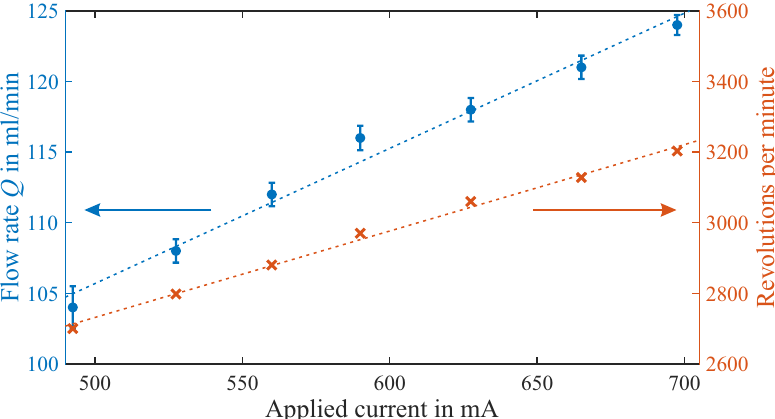
Figure 8. Measurement results for average flow rate Q (blue dots, left axis) and rotation speed (orange crosses, right axis) plotted over applied current, with dashed lines as linear